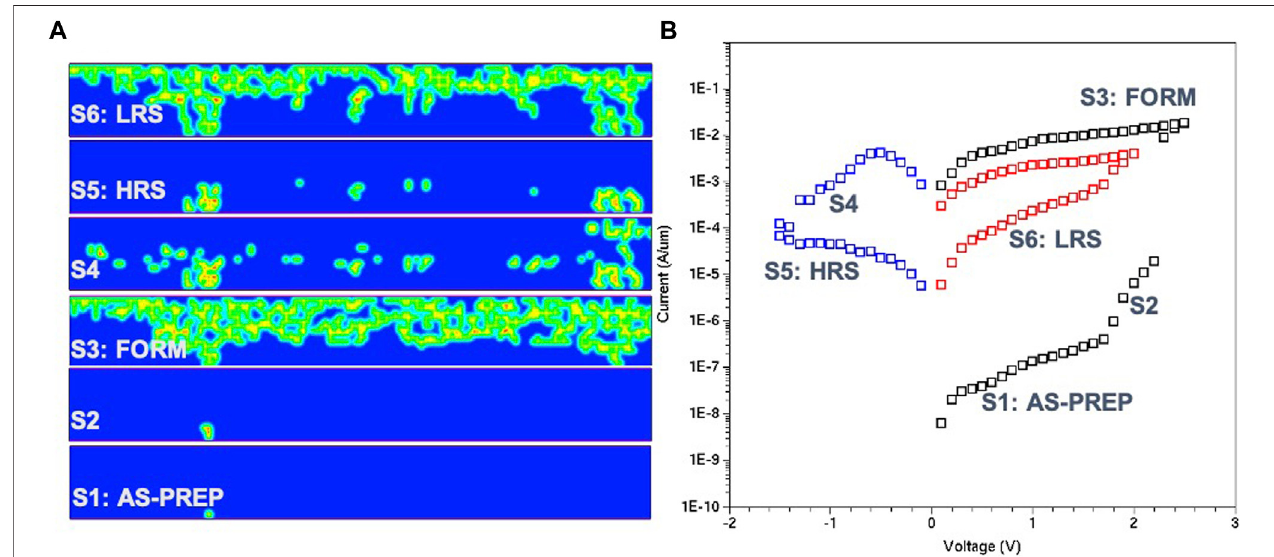
FIGURE 7 | (A) Filament positions corresponding to different points along the programming sequence (forming, reset, set). (B) Pulsed IV characteristics for the complete programming sequence.